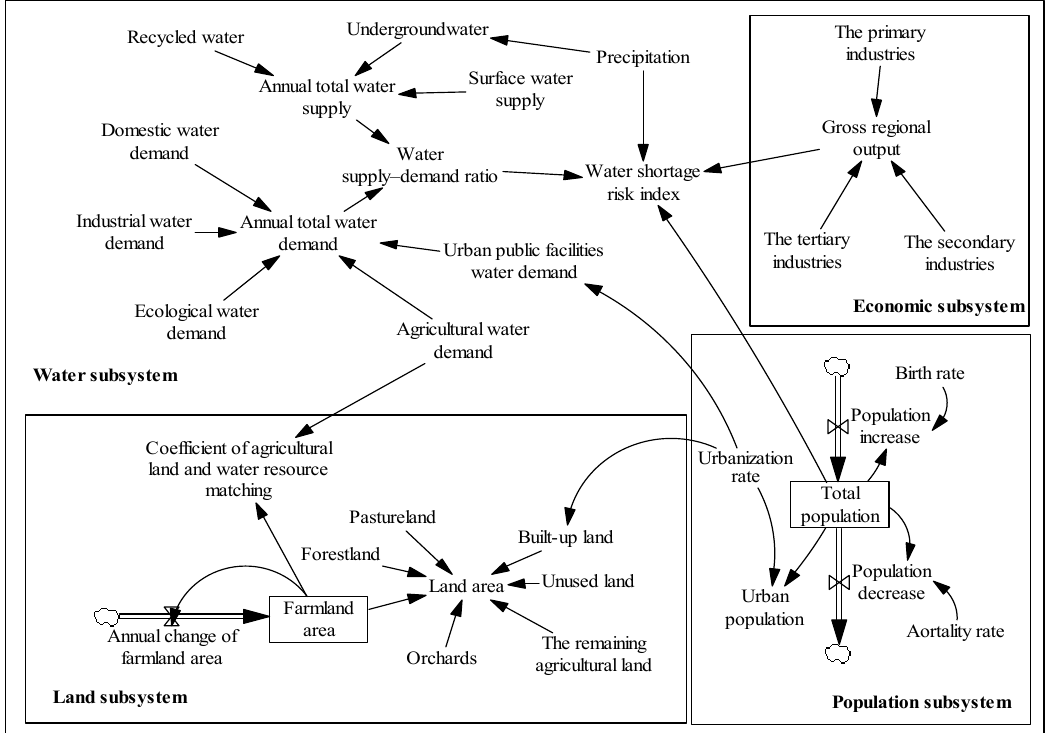
Figure 2. Subsystem interconnection overview.